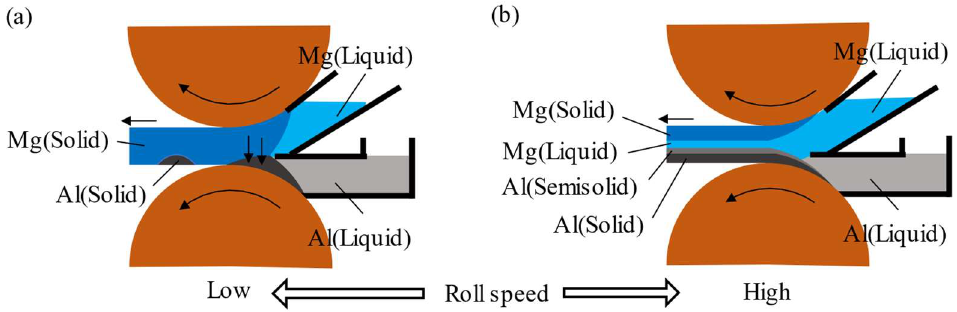
Figure 7. Casting process at different roll speeds. ( a ) Low speed, ( b ) High speed.